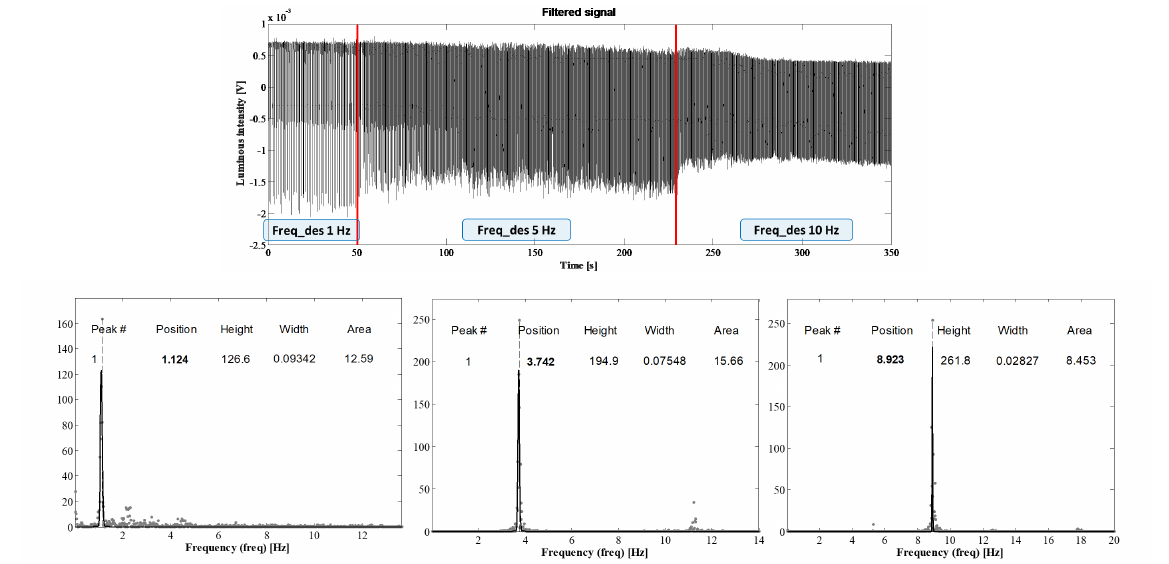
Figure 11. Signal acquired by the Labview platform during a real-time experiment in which the value of the desired frequency was changed freq des = { 1,5,10 } Hz. The three time windows showing the different dynamics were highlighted and labelled with the values of the desired frequency. The three spectra were computed and the detected peaks are freq act = { 1.12,3.74,8.92 }